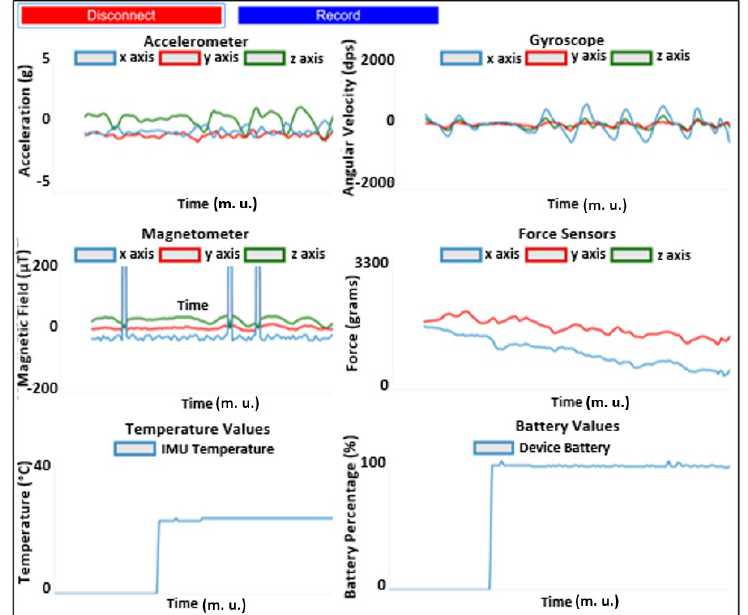
Figure 8. Chrome JavaScript web application for real-time data visualization and saving. Graphics enumeration from top to bottom and left to right: accelerometer, gyroscope, magnetometer, both analog sensors (force sensors used for this example), temperature and device battery percentage.